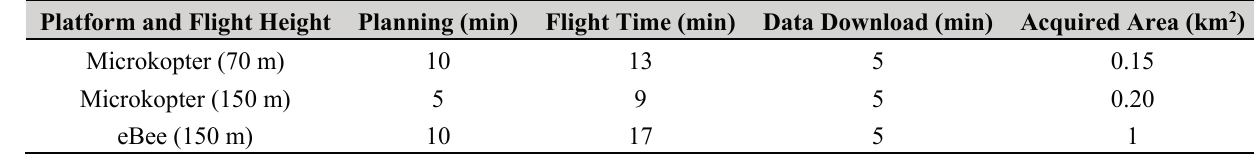
Table 3. Time required for each flight step for the different test